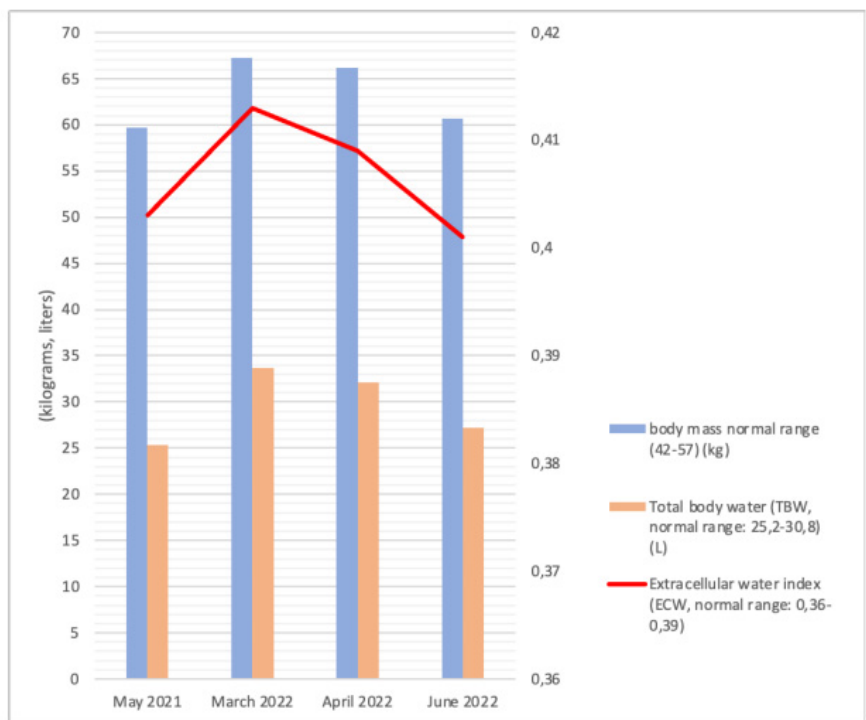
Figure 3. Relationship between body weight, total body water, and the extracellular water ratio.